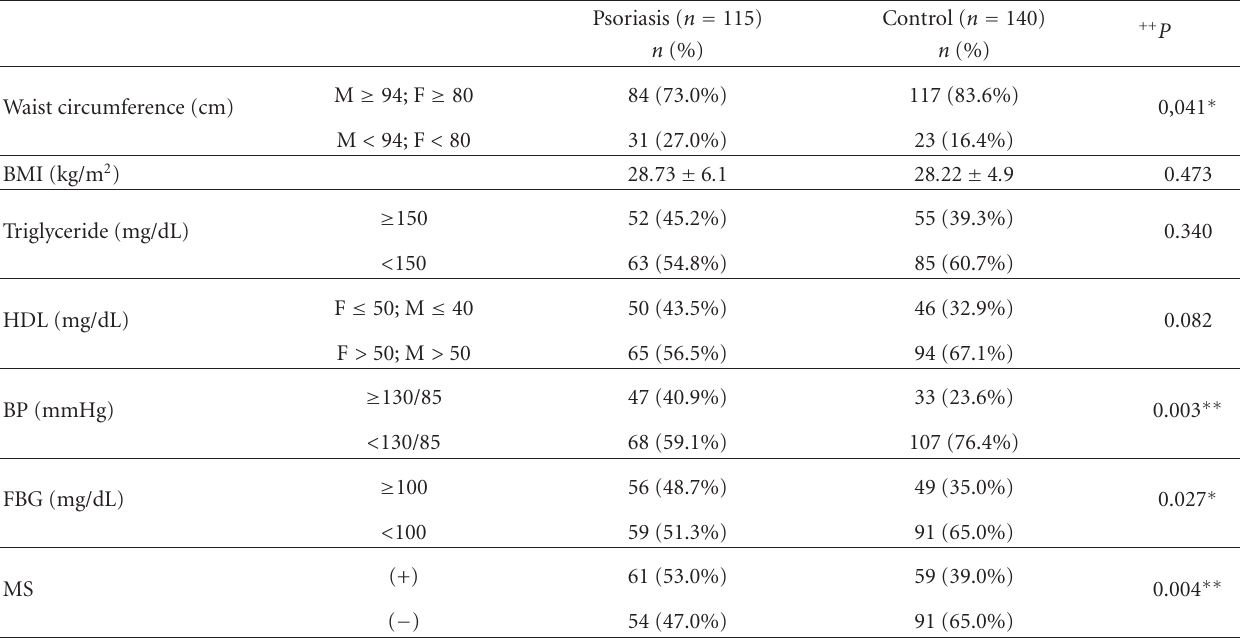
Table 1: Metabolic syndrome criteria in psoriasis patients and controls.